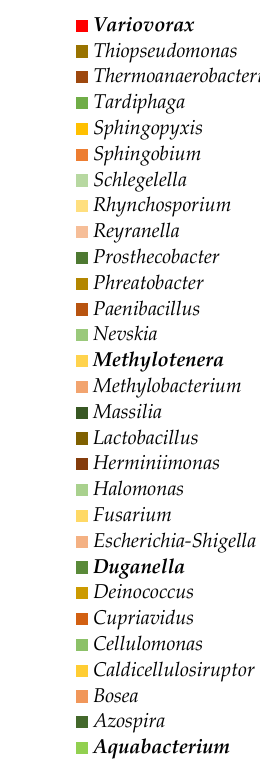
Figure 3. Relative abundance of the main bacteria genera in the biofilm samples.